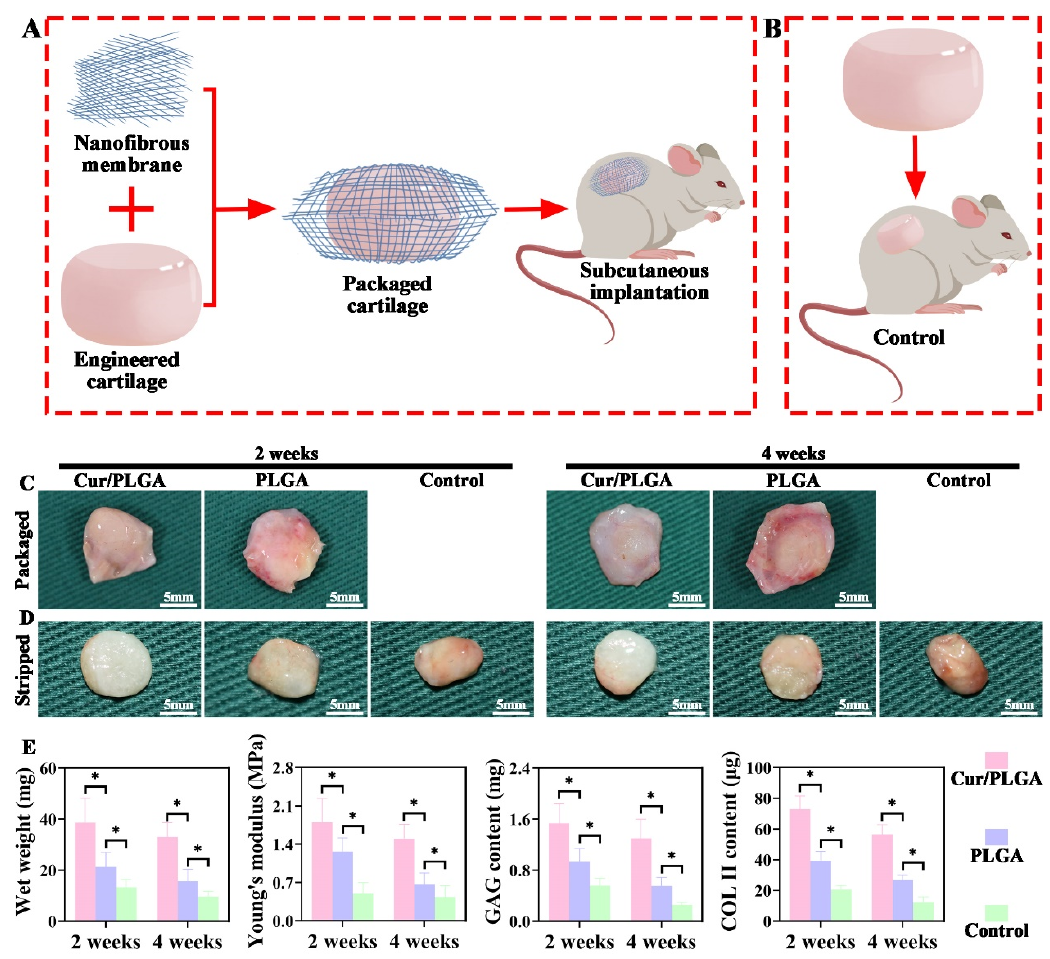
Figure 5. Subcutaneous implantation of nanofibrous-membrane-packaged cartilage tissues for 2 and 4 weeks: The schematic illustration of the preparation and subcutaneous implantation of nanofibrous-membrane-packaged cartilage tissue in rats ( A ) and the corresponding control groups ( B ). Images of the nanofibrous-membrane-packaged cartilage tissue in the curcumin/poly(lactic-co-glycolic acid) (Cur/PLGA) and PLGA groups ( C ). Images of the nanofibrous-membrane-stripped cartilage tissue in the Cur/PLGA and PLGA groups and the corresponding control group ( D ). Quantitative analysis of wet weight, Young’s modulus, glycosaminoglycan (GAG) content, and COL II content in the nanofibrous-membrane-stripped cartilage tissue of the Cur/PLGA, PLGA, and control groups ( E ). * p < 0.05.